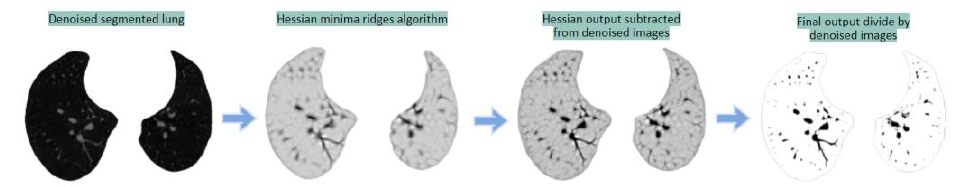
Figure 20. Hessian-based segmentation process.